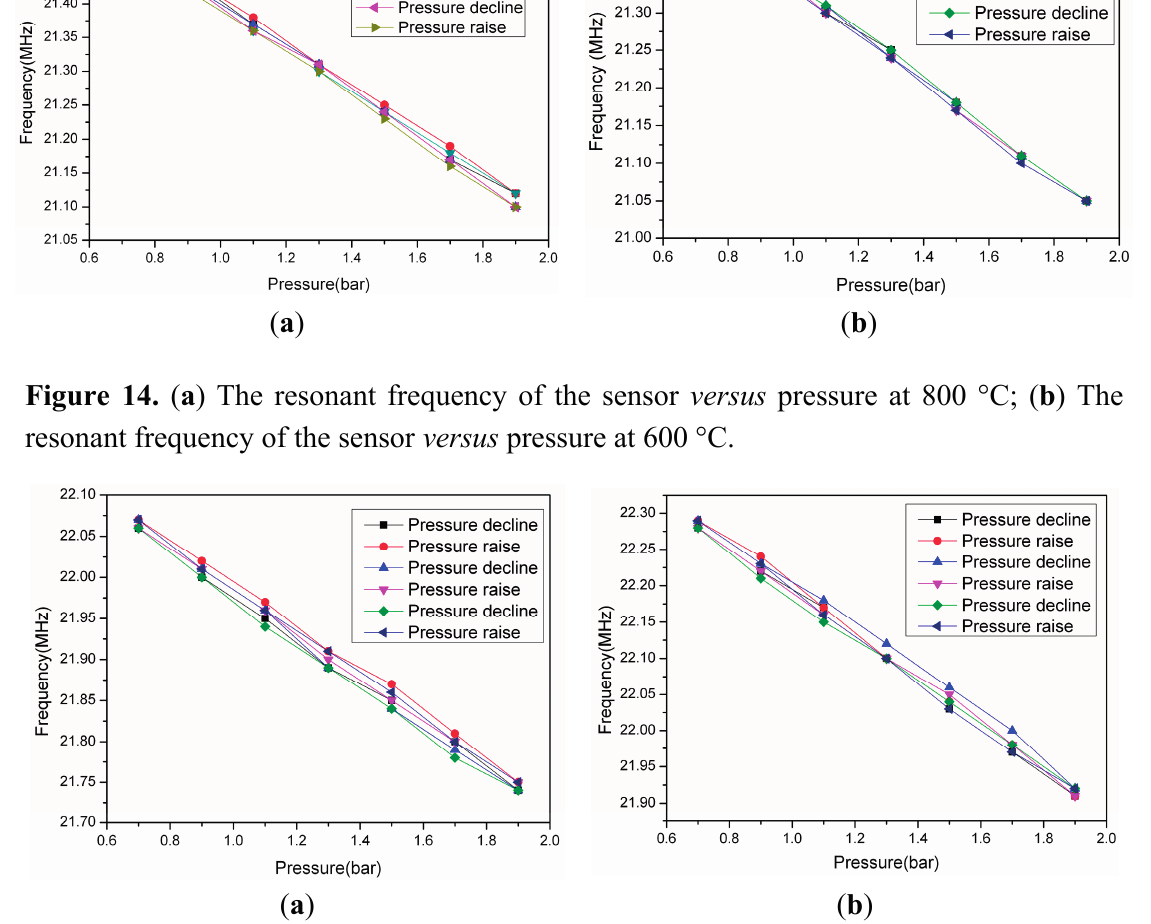
Figure 15. ( a ) The resonant frequency of the sensor versus pressure at 400 °C; ( b ) The resonant frequency of the sensor versus pressure at 200